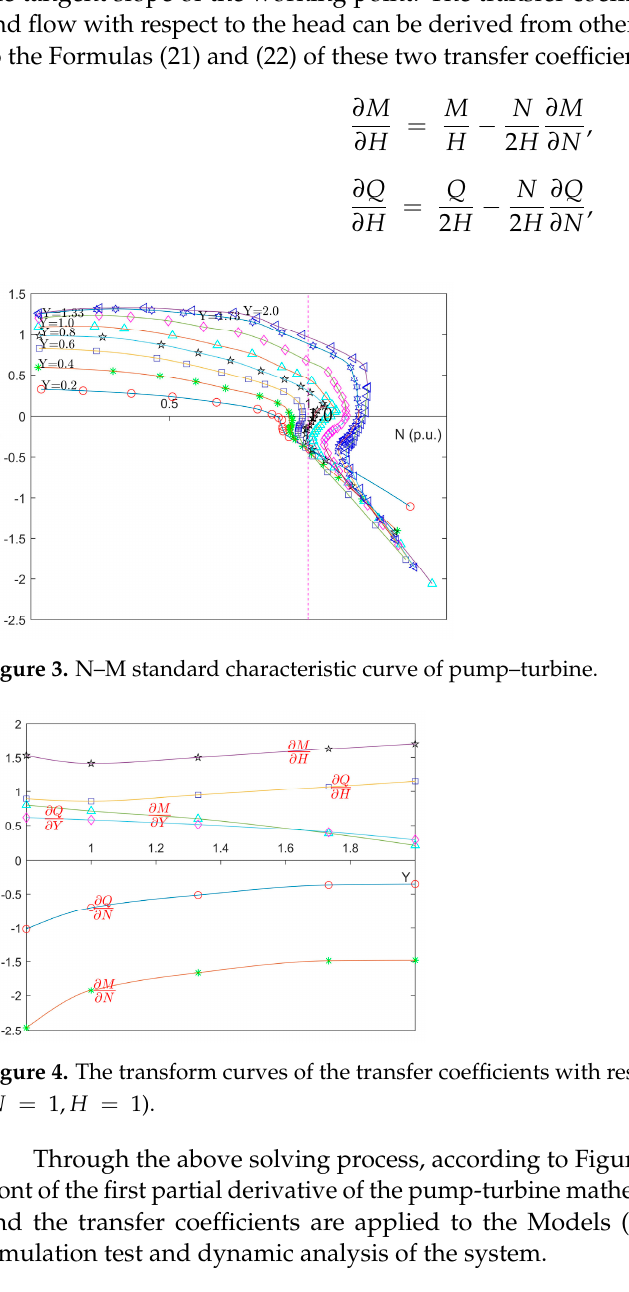
Figure 3. N–M standard characteristic curve of pump–turbine.